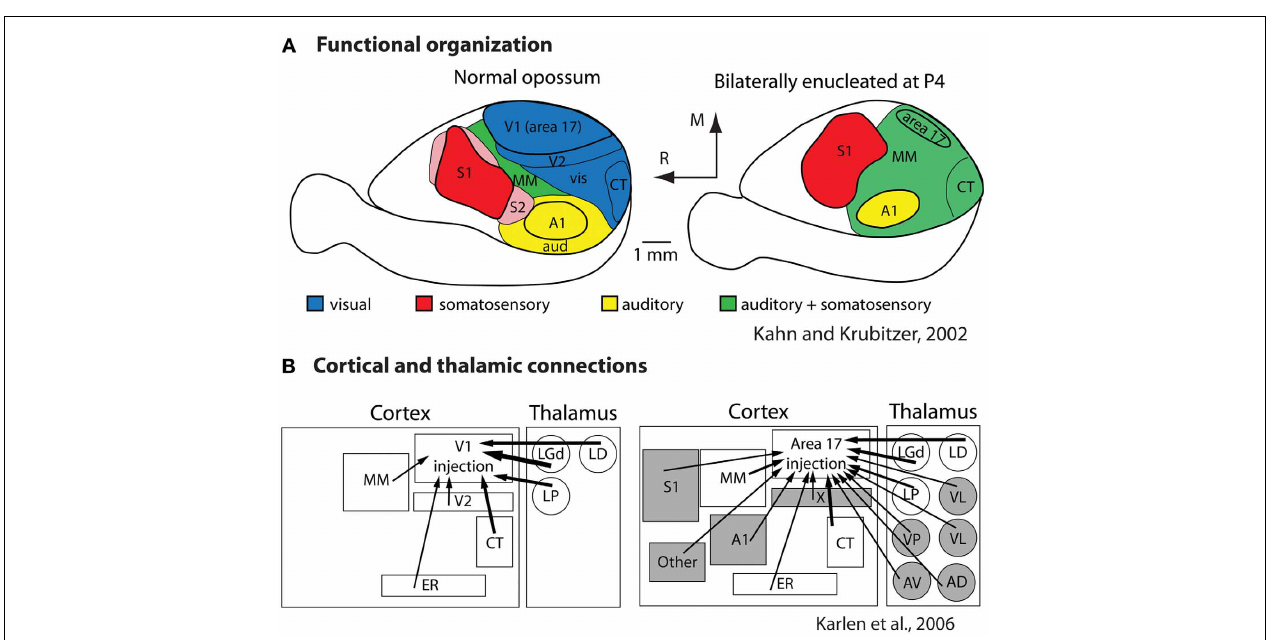
FIGURE 8 | Alterations in the functional organization (A) and connectivity (B) in bilaterally enucleated opossums. In normal animals (left) much of cortex is devoted to visual processing. With early and complete loss of vision (right) all of what would normally develop into